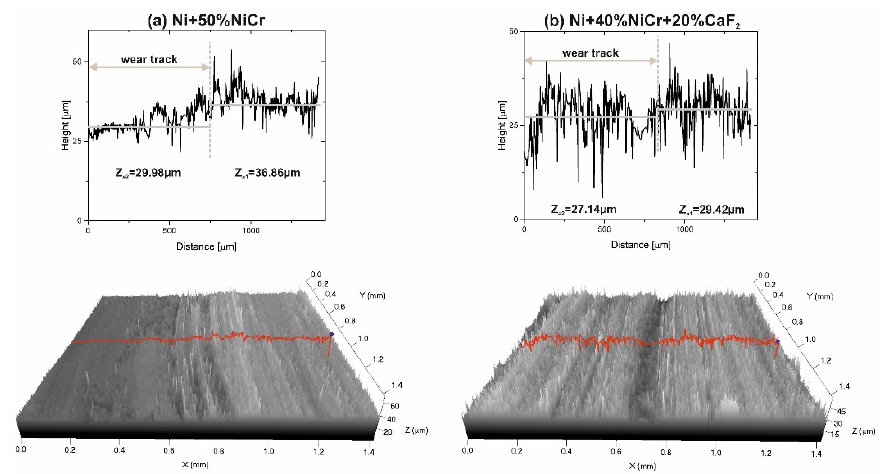
Figure 11. Stereometrics profiles of the counter-samples combined with Ni-50%NiCr(80/20) ( a ) and Ni-40%NiCr(80/20)-20%CaF 2 ( b ), after wear test at 200 °C.